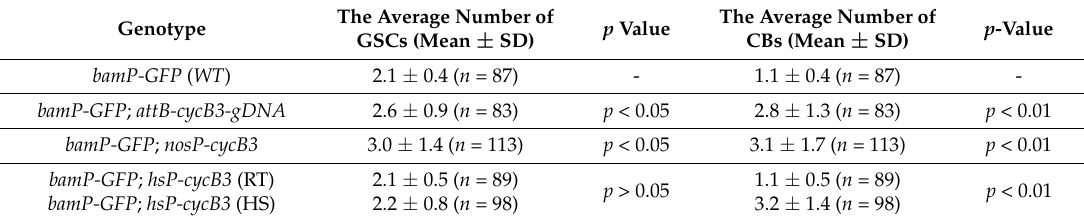
Table 2. Overexpression of cycB3 dramatically increases the average number of Cystoblasts (CBs). The Average Number of Genotype GSCs (Mean ±